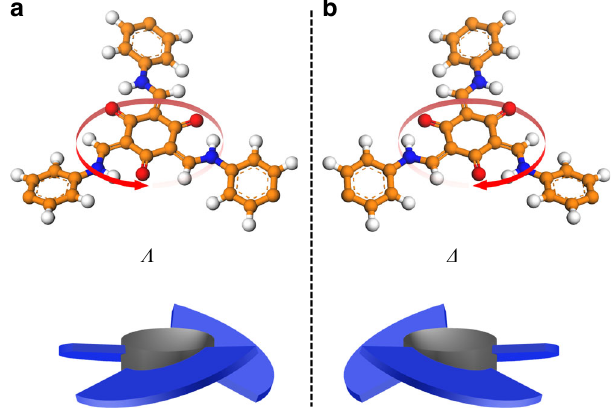
Fig. 1 The modeling of propeller-shaped TASN-based conjugated structures. a and b are ( Λ ) - and ( Δ )-isomers of TASN-based conjugated structures in COFs,